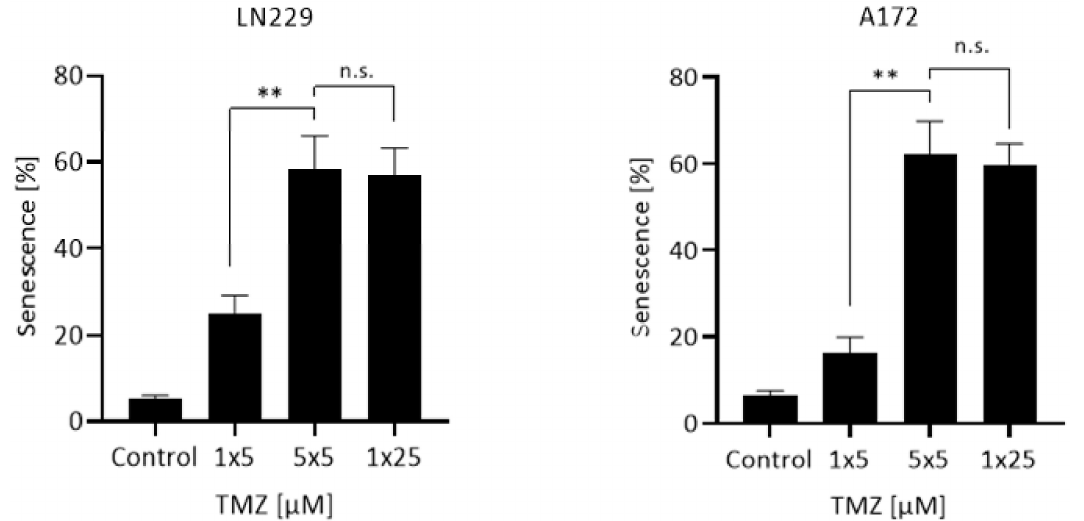
Figure 2. CSEN induced in LN229 and A172 cells following treatment with a single dose of 5 µ M, repeated doses of 5 µ M, and a single dose of 25 µ M. Data are presented as mean of three independent experiments with triplets measured ± SEM and compared by unpaired t -test with Welch’s correction. n.s. = not significant; ** p <